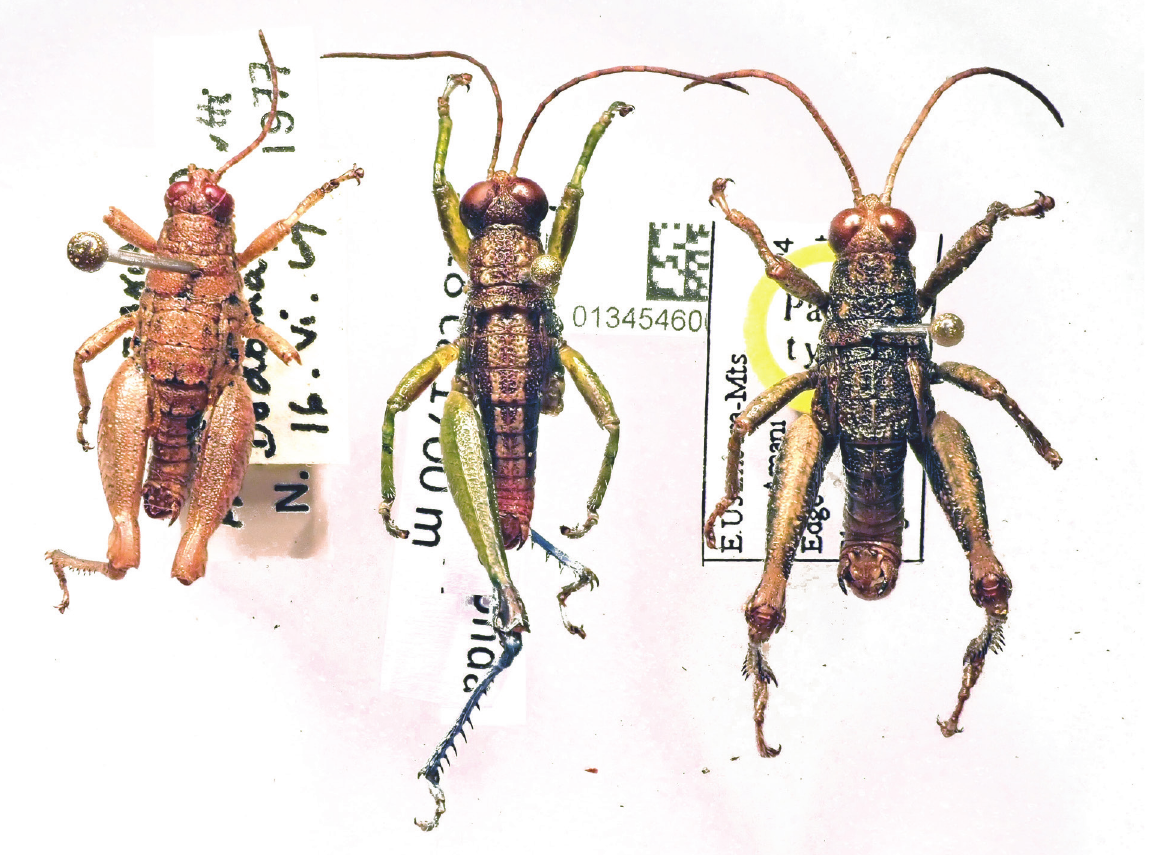
Fig. 7. Dorsal habitus of male Physocrobylus species. From left to right: P. burtti , P. venetus sp. nov. , and P. tessa